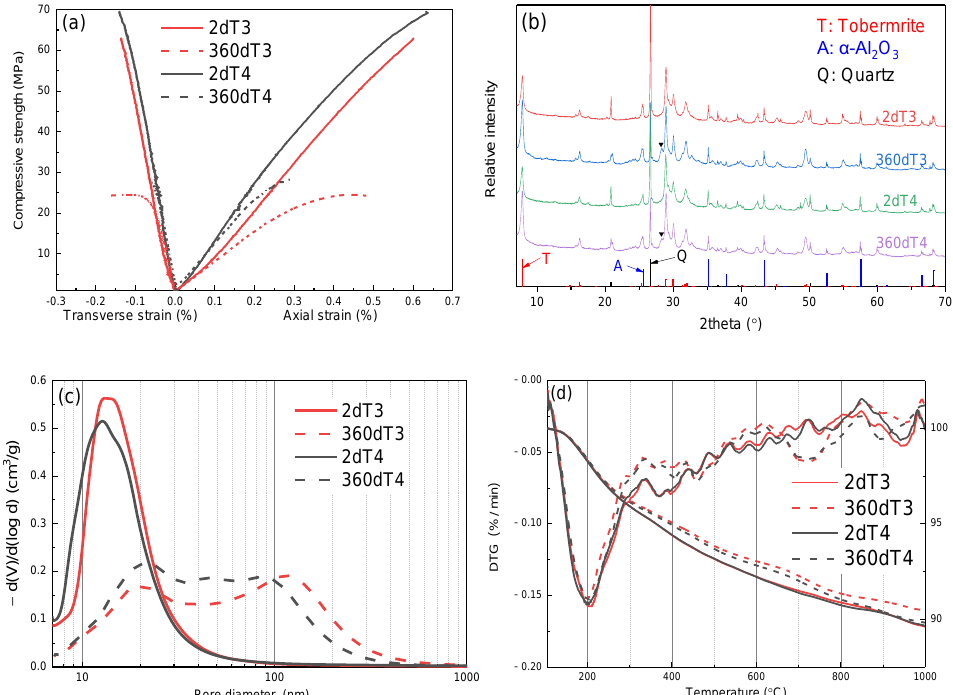
Figure 5. Relationship between macroscopic properties and microscopic properties of slurries T3 and T4 cured under 200 °C and 150 MPa from 2 to 360 d. ( a ) Stress – strain response showed decreasing resistance to load; ( b ) XRD test showed possible C-S-H structural change; ( c ) MIP test showed increasing pore diameter; ( d ) TG test showed decreasing bound water content measured between 200 and 650 °C.